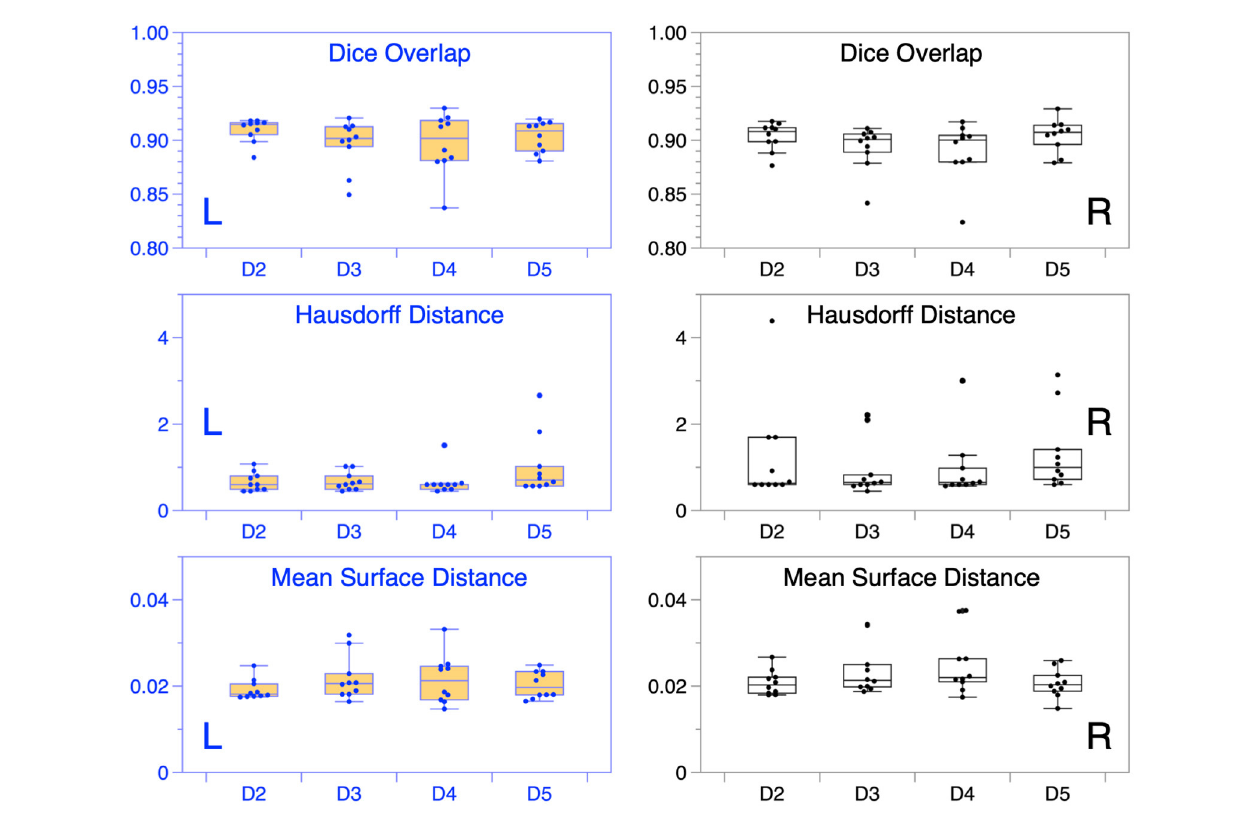
FIGURE 5 | IE-Vnet segmentation quality control. Alignment between ground-truth and prediction in the four test datasets D2-D5 (20 IE each, 80 IE altogether) was measured by the quantitative metrics of Dice overlap coefficient (upper row) , Hausdorff maximum surface distance (middle row) , and average surface distance (lower row) . Results of left ears (blue) are depicted on the left (L), while results of the right ears (black) are shown on the right (R). In most cases across D2-5, congruence between model prediction and manual ground-truth was high.